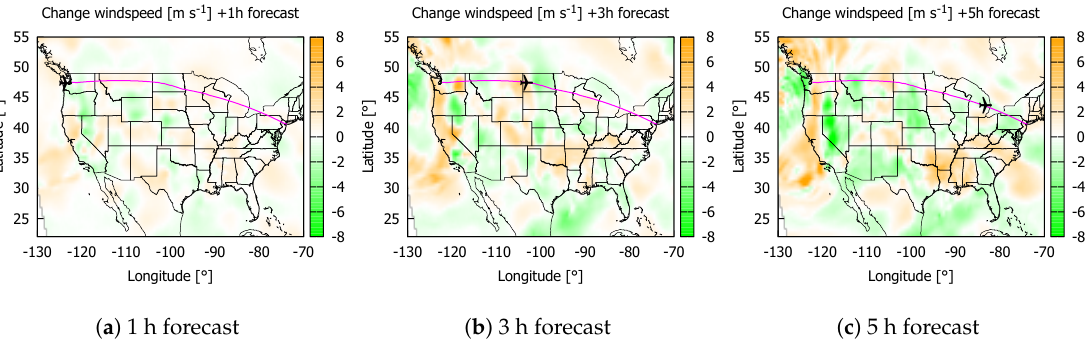
Figure 1. Increasing inaccuracy of weather forecasts shown as differences in wind speed [ms − 1 ] between the used weather cycle (GFS, 31 January 2020, Cycle 00) before departure ( a ), and the latest available Rapid Refresh cycle during flight ( b , c ). More intensive colors mean more erroneous